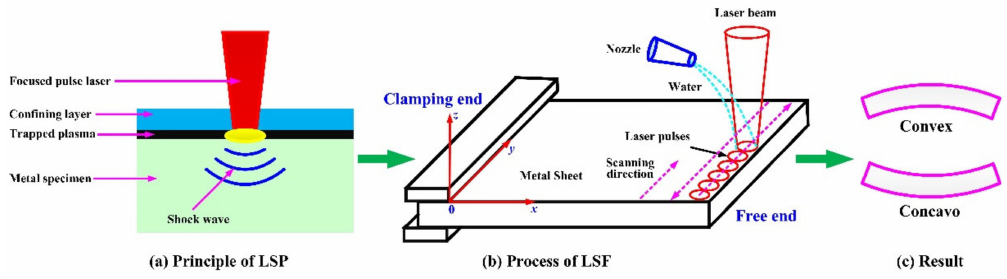
Figure 5. The schematic of LSF